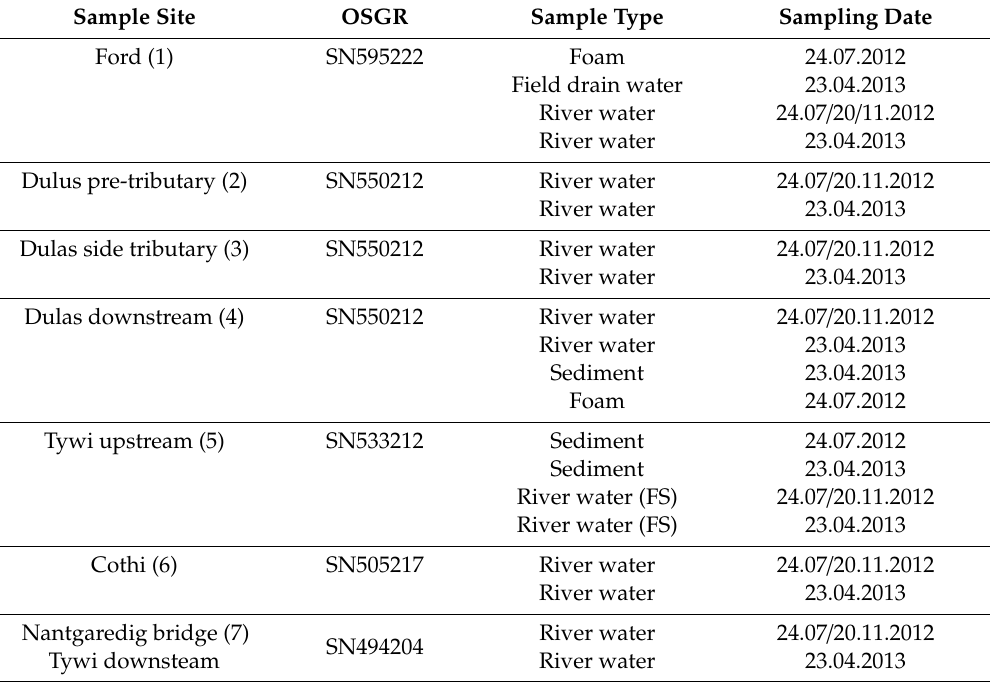
Table 3. Sample sites for Fine sampling